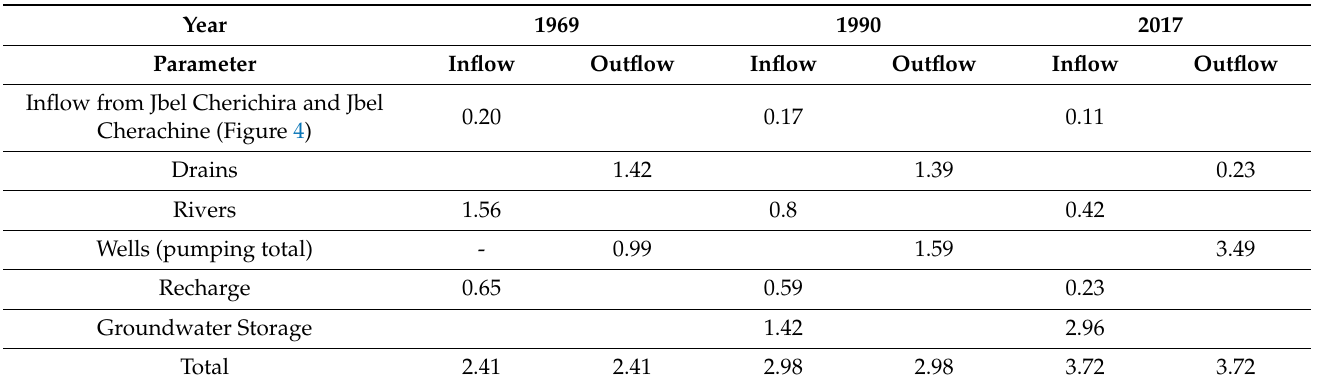
Table 2. Water balance was simulated by the model in 1969 and 2017 (m 3